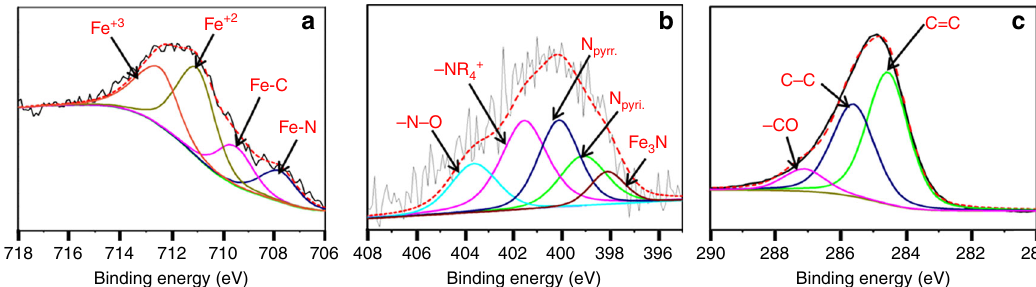
Fig. 5 X-ray photoelectron spectra (XPS) of Fe-L 1 @EGO-900. a Iron. b Carbon. c Nitrogen